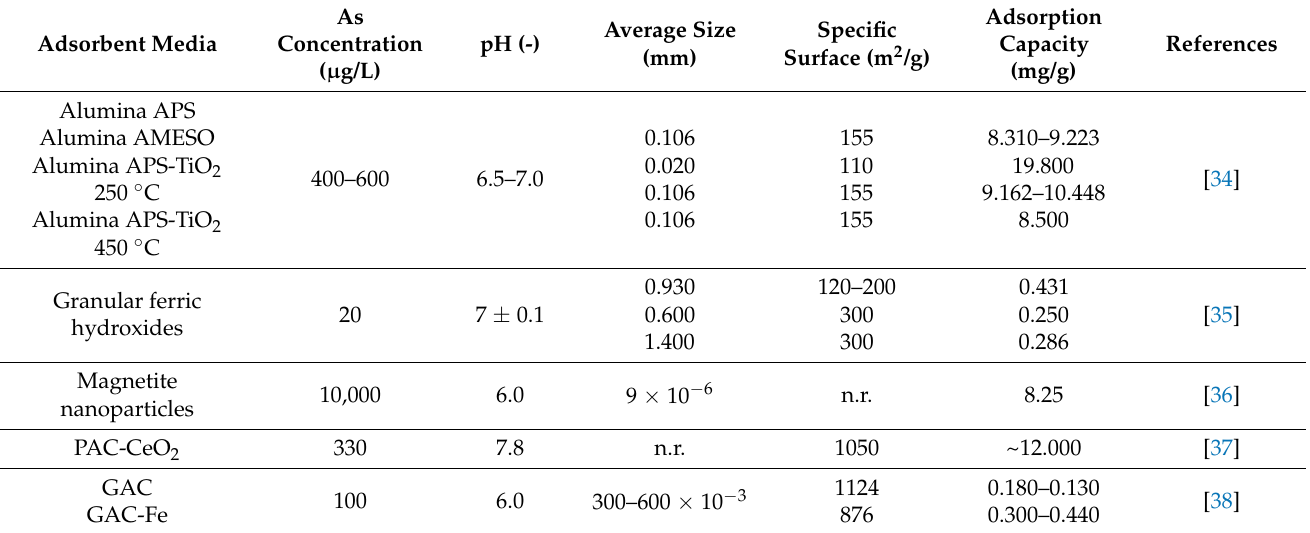
Table 1. Adsorbent materials investigated for arsenic adsorption from contaminated water.